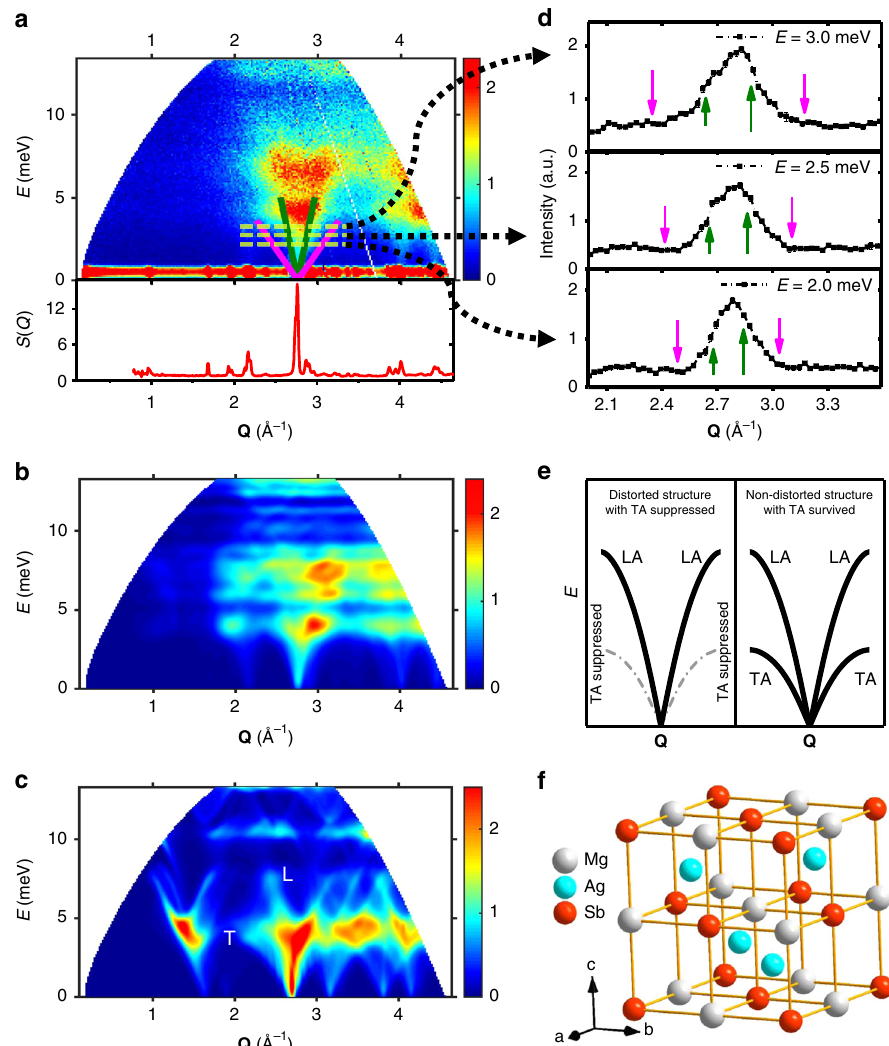
Fig. 3 Transverse acoustic phonon suppression by the static local structure distortion. a Bose-factor-calibrated dynamic structure factor, B ( Q , E ), measured with INS (top) and static structure factor, S ( Q ), measured with neutron total scattering (bottom) at 300 K in MgAg 0.965 Ni 0.005 Sb 0.99 . The magenta and green lines are calculated dispersions based on transverse and longitudinal sound velocities, respectively, which were measured by the resonant ultrasound spectrometer method. b The corresponding neutron-weighted ab initio calculated B ( Q , E ) pattern using the OCLIMAX program for α -MgAgSb. c The corresponding neutron-weighted ab initio calculated B ( Q , E ) pattern based on an adjusted symmetric Ag atom- fi lled Mg – Sb rocksalt structure. d E- cut data at 2.0, 2.5, and 3.0 meV. The magenta and green arrows indicate the transverse and the longitudinal phonon peak positions, respectively, which are calculated by the sound velocities. Error bars are propagated from counting statistics on measured spectra; a.u., arbitrary units. e A schematic shows transverse acoustic phonon suppression by the static local structure distortion. f The adjusted symmetric Ag atom- fi lled Mg – Sb rocksalt structure used in c calculation. By comparing b with c , the transverse acoustic phonons are observed to survive in the symmetric structure while they disappear in the distorted structure e . These results demonstrate that the transverse acoustic phonons are mostly suppressed by the distorted structure in this material. For the purpose of comparison, the color bars in a , b , and c are plotted in relative intensities with arbitrary